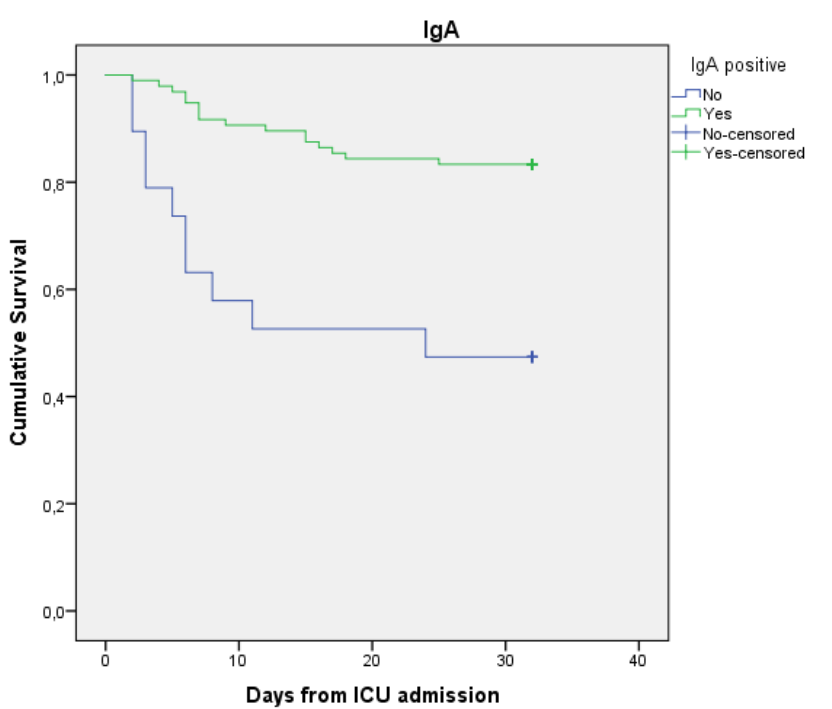
Figure 1. Kaplan–Meier curves describing survival after hospital admission for patients positive vs. negative for SARS-CoV-2 antibodies in plasma. Table 2. Comparison between patients with or without anti-SARS-CoV-2 antibodies.